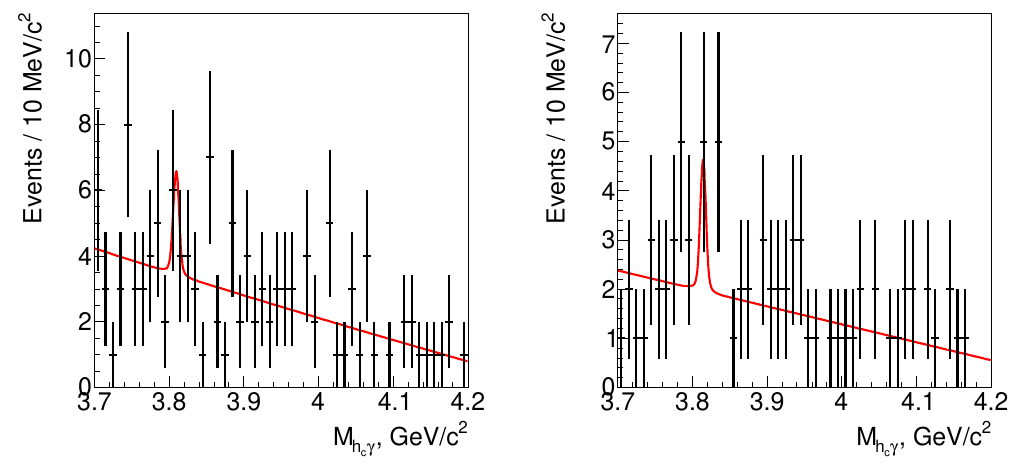
Figure 4 . Fit results for the channels B +